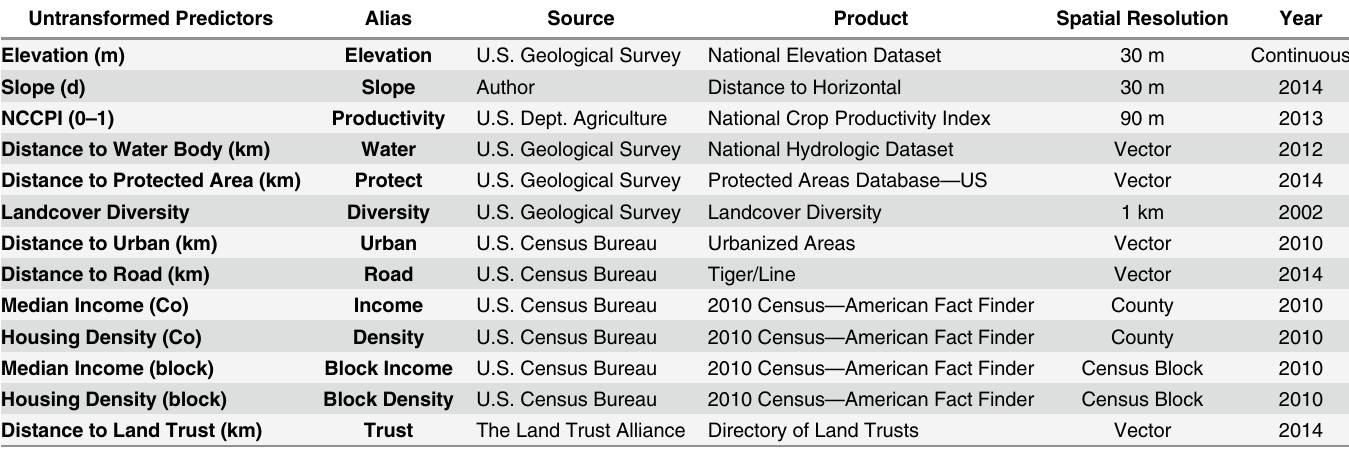
Table 1. Predictor variables, aliases used, source of data, product name or derived product, spatial resolution, and year released to public. Untransformed